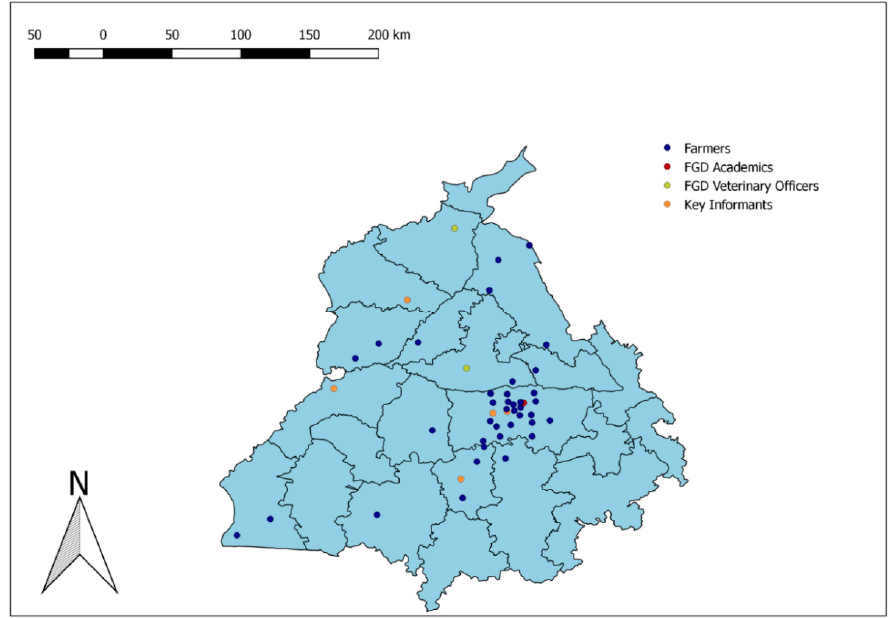
Figure 1. Locations of the residences and workplaces of farmers and veterinary practitioners who participated in the seven focus group discussions (FGDs) and five key informant interviews (KII) conducted during the study of the dairy value chains in Punjab state of India, 2018–2019.